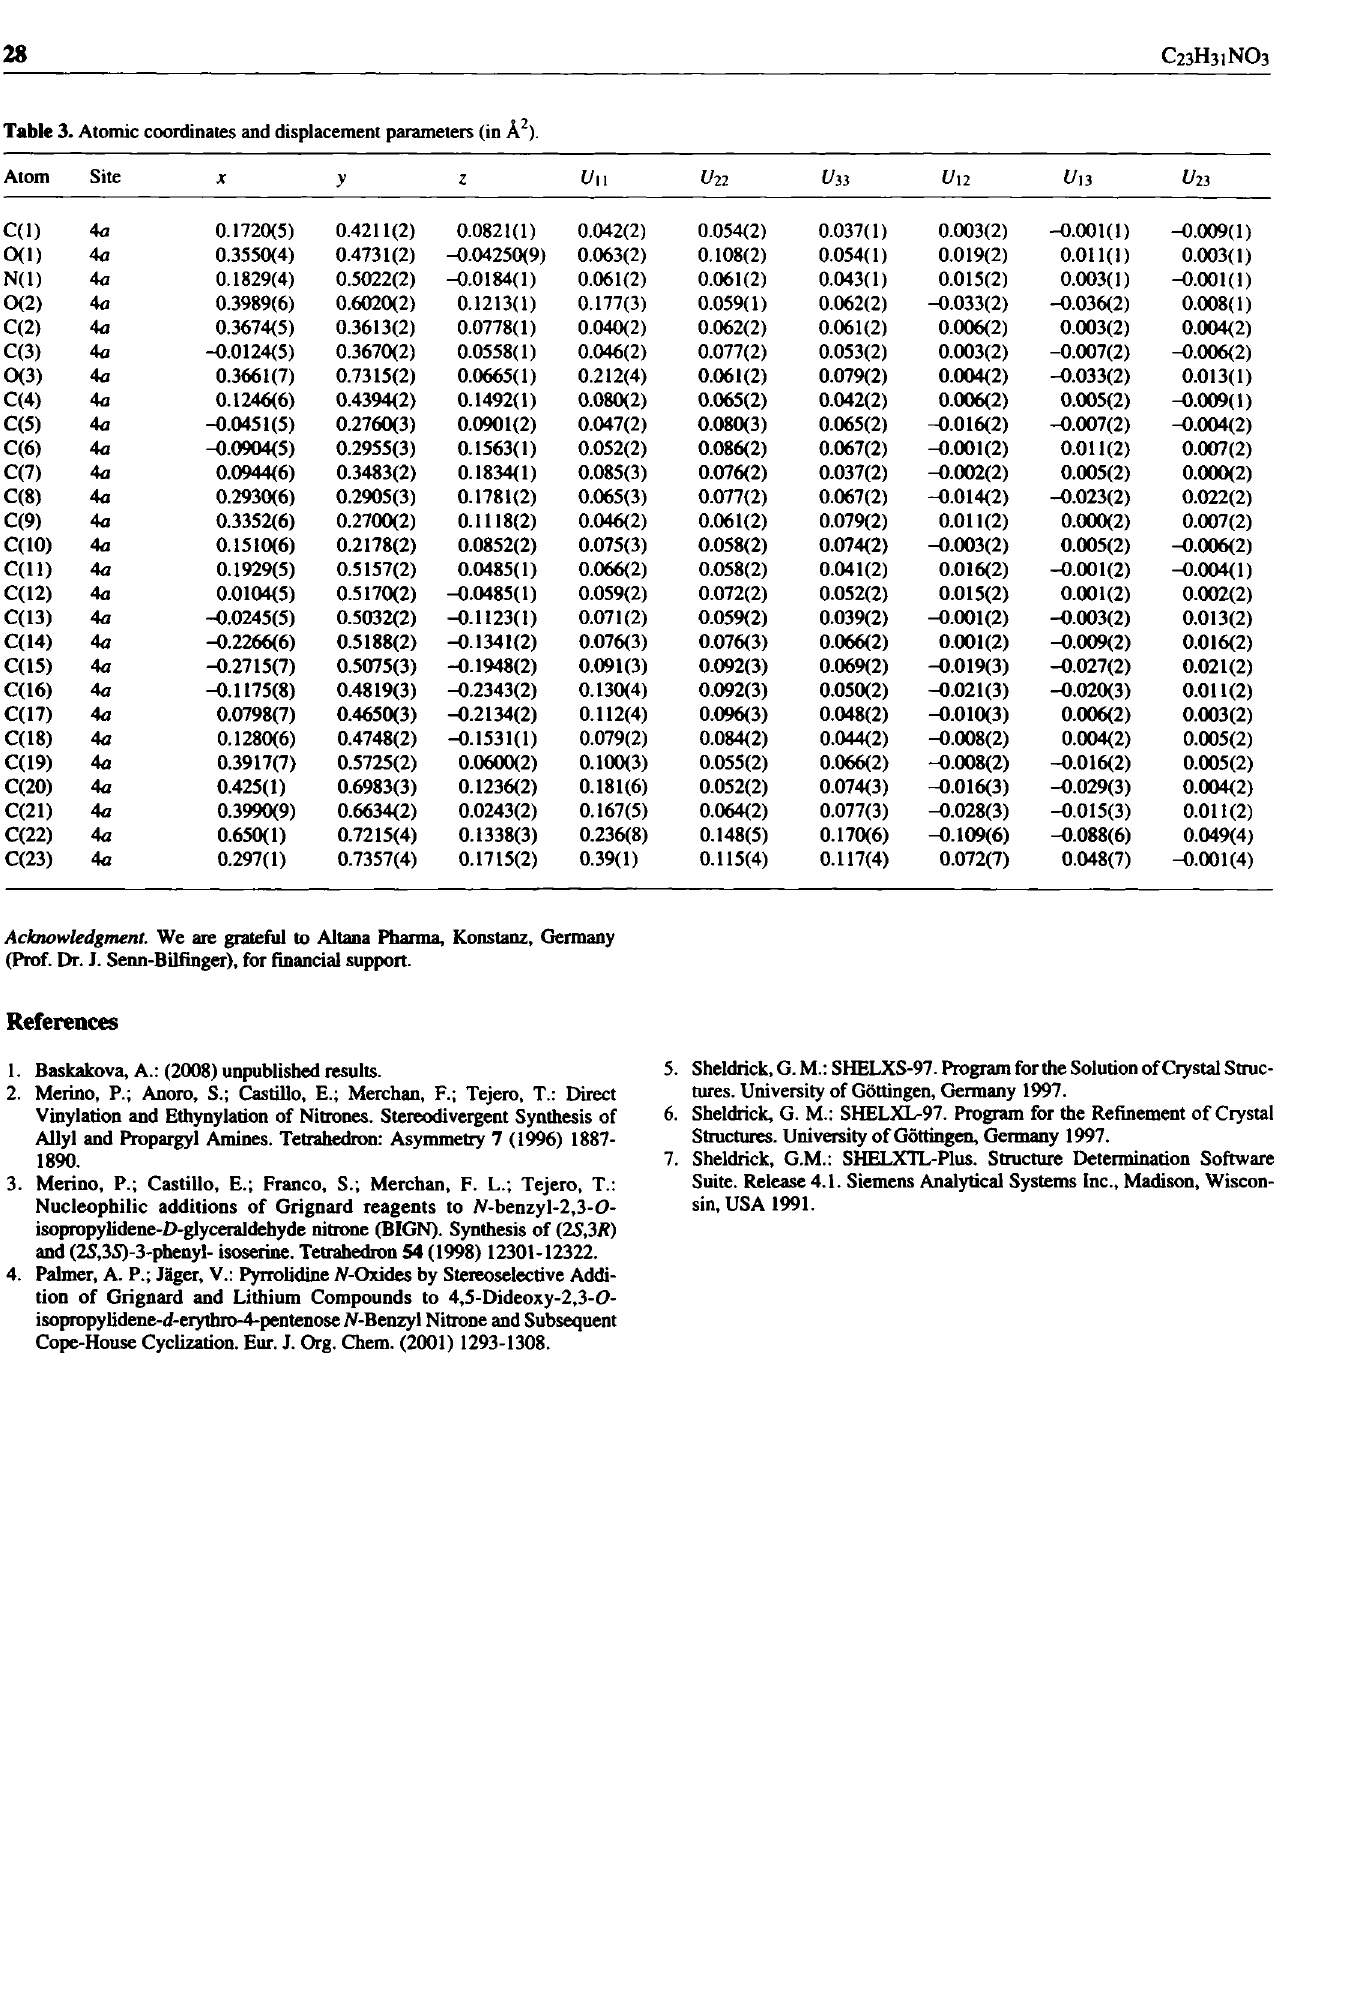
Table 3. Atomic coordinates and displacement parameters (in Â 2